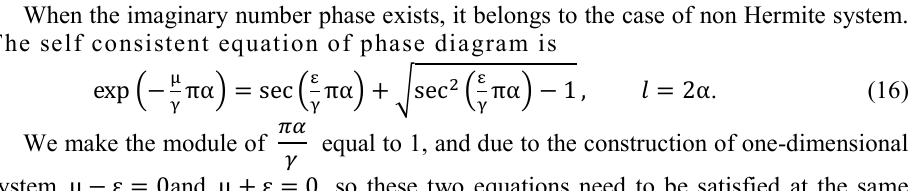
, when , the relationship 𝑙𝑙 = 1 n = 1,2,3